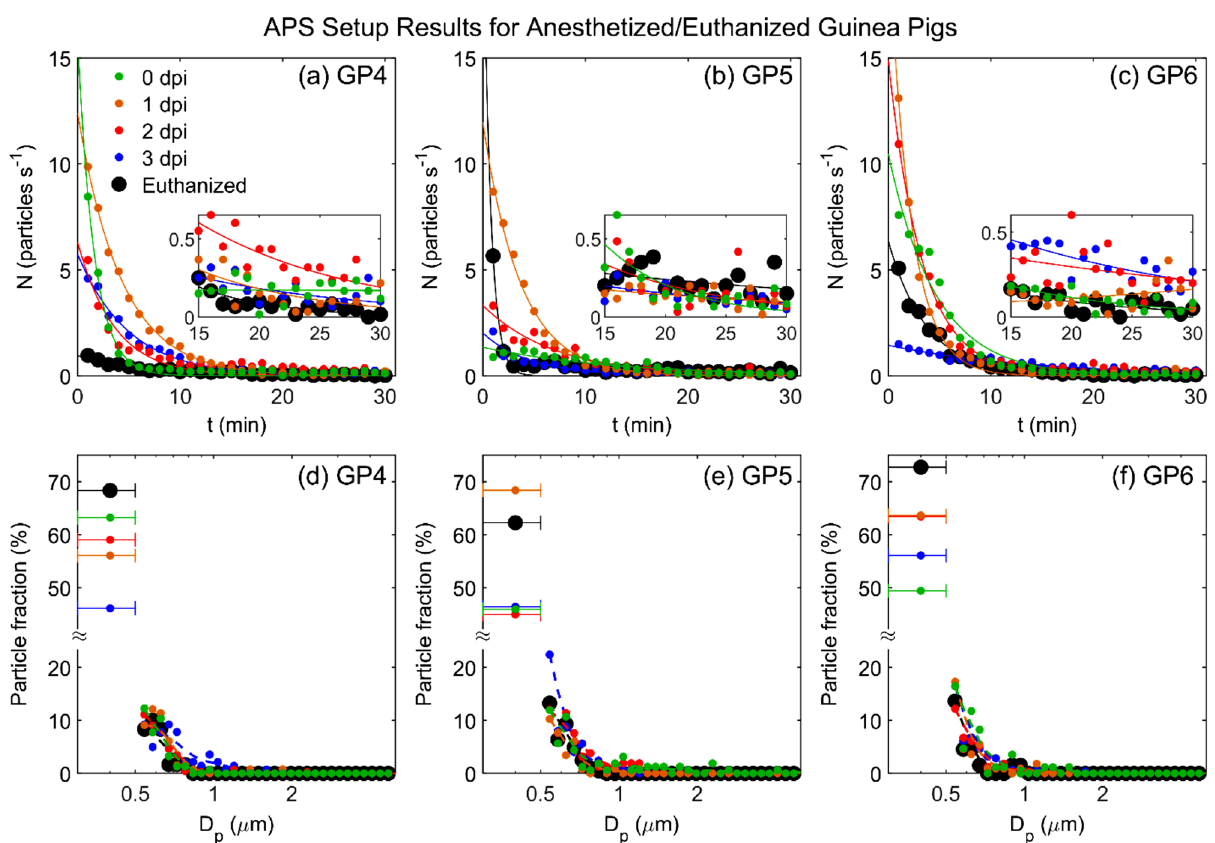
Figure 4. Particle emission from anesthetized or euthanized guinea pigs measured by the APS setup. Particle emission rate, N , versus time under 5 conditions: uninfected anesthetized guinea pig (0 dpi), inoculated anesthetized guinea pig at 1, 2, and 3 dpi, and euthanized guinea pig, for ( a ) GP4, ( b ) GP5, and ( c ) GP6. Magnifications show the final 15 min of each set. ( d – f ) Corresponding size distribution for particles emitted during the last 15 min of the measurements shown in ( a )–( c ). The left-most data points in each plot shows the fraction of particles counted in the 0.3–0.5 μm bin, which cannot be further size-discriminated. The whiskers represent the width of the bin (0.3–0.5 μm). Dashed lines represent the data using a 5-point smoothing function. Data indicated by red and black markers in ( d ) for GP4 at 2 dpi and euthanized, respectively, are reproduced from Asadi et al. 24 and included here for